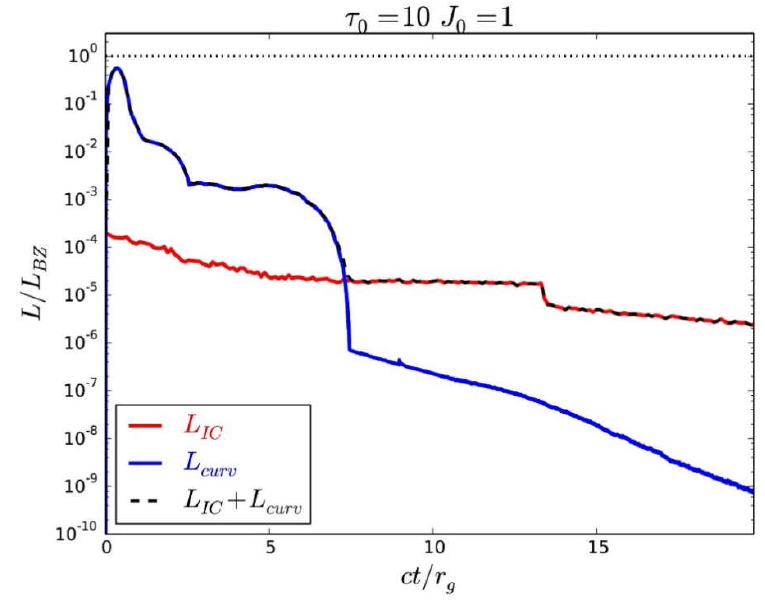
Figure 5. Gamma-ray light curve produced by the gap discharge. The red line corresponds to inverse-Compton (IC) emission, the blue line to curvature emission, and the black dashed line to the sum of both components. Adapted with permission from [81].